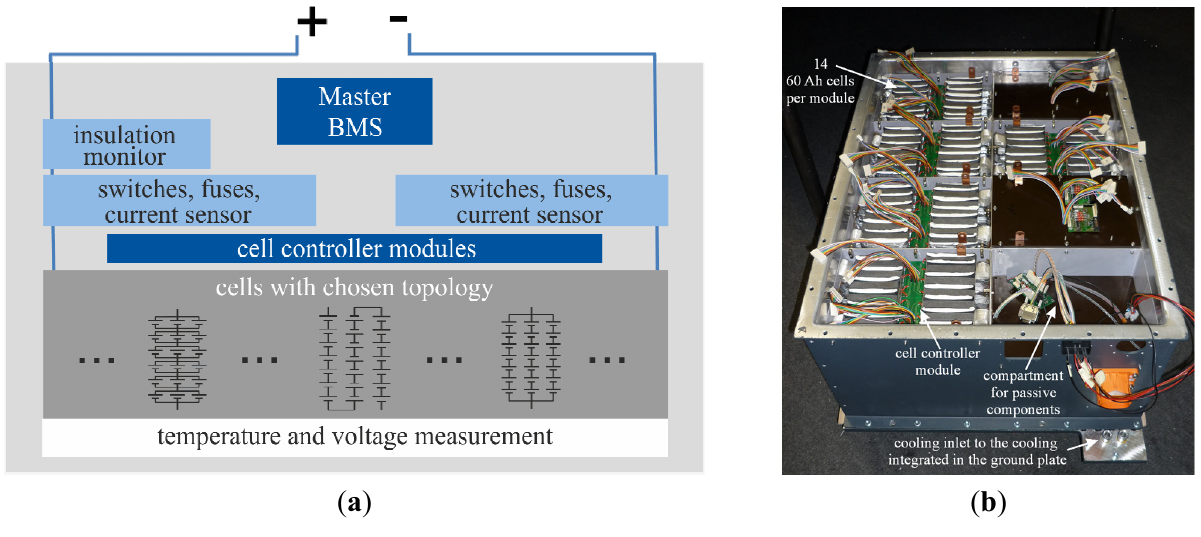
Figure 6. Layout of a battery system: Schematic structure ( a ) and Smart Wheels pack ( b ). By connecting more cells in parallel, the redundancy is enhanced as a single cell fault does